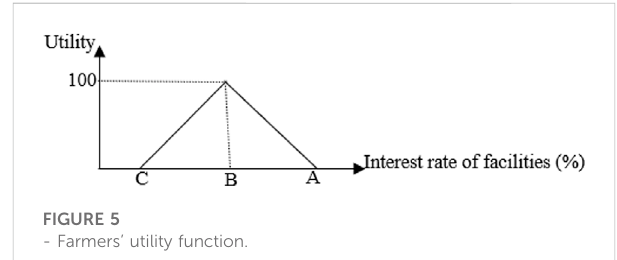
FIGURE 5 - Farmers ’ utility